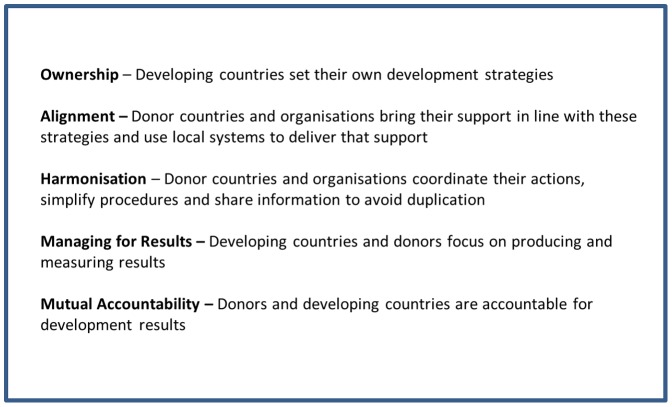
Paris Principles.